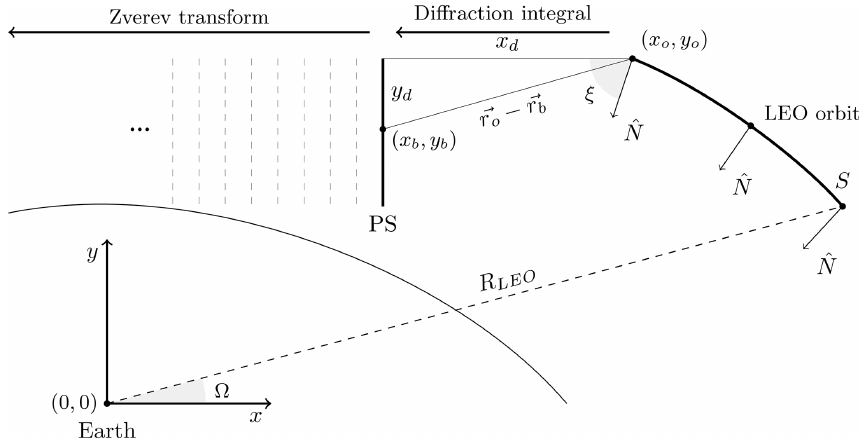
Figure 3. Back-propagation geometry. The diffraction integral is computed along the LEO orbit path ( S ) and projected to every point on the closest PS. Once the back-propagated signal is available on the auxiliary plane, the Zverev transform is computed iteratively towards the GPS